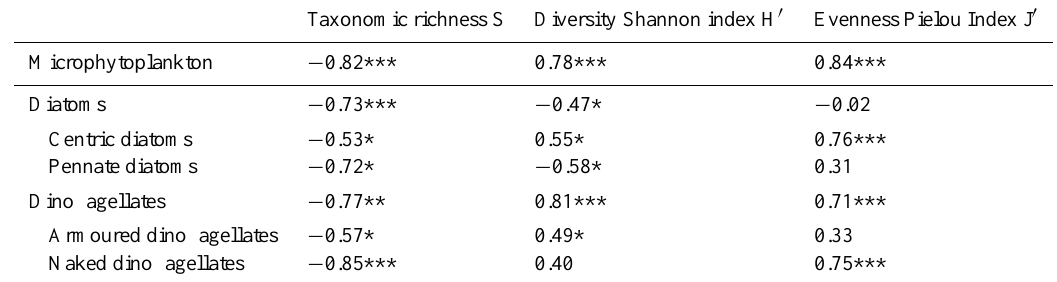
Fig. 4. Evolution of the stratification index in relation to the biodiversity descriptors of the main groups of the microphytoplankton during DYNAPROC 2 cruise, from hydrological bottle and net sampling (a) Stratification index, (b) Taxonomic richness, (c) Diversity Shannon’s index, (d) Evenness Pielou’s index. Table 3. Spearman rank correlations between the stratification index ( 8) and taxonomic richness, diversity Shannon index and evenness Pielou index of the microplankton